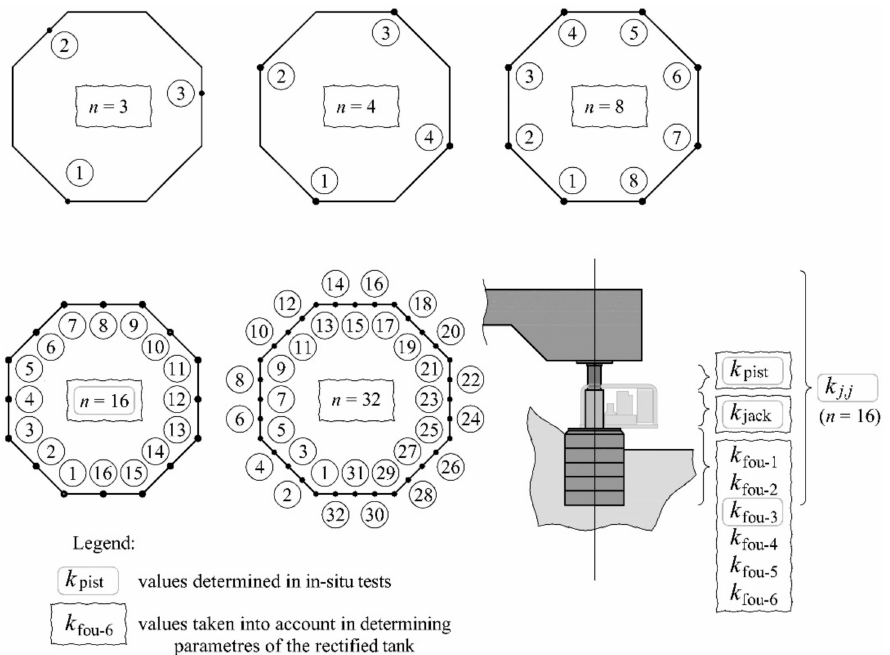
Figure 4. Values determined during the in-situ tests ( k pist , k jack , k fou-3 ) and the model variables ( n , k fou ), for which the parameters k , f obj and f fou of the rectified tank were calculated ( k fou-1 < k fou-2 <